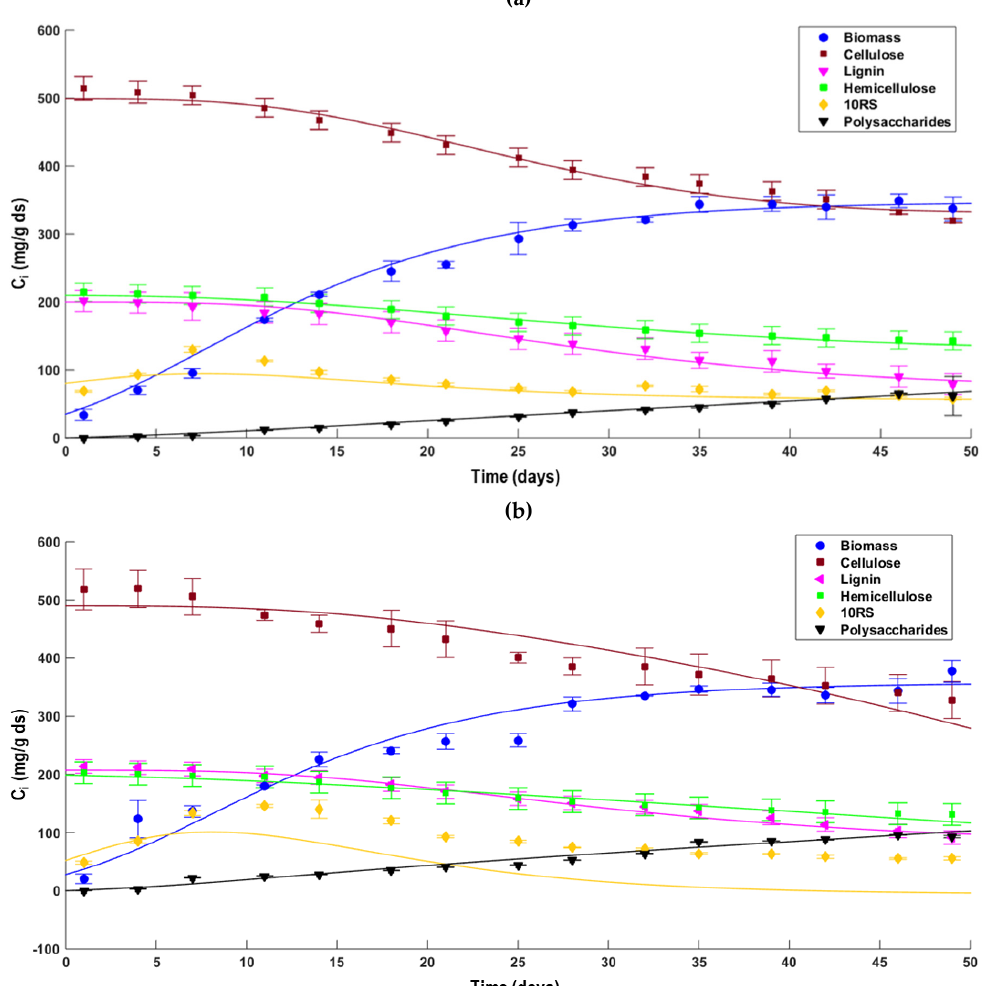
Figure 5. Time profile of cell biomass, polysaccharide production, and cellulose, hemicellulose, and lignin degradation by T. versicolor grown on different solid media. ( a ) Kinetic behavior for F7 medium. ( b ) Kinetic behavior for F11 medium. The continuous lines were calculated by the model proposed. The values for reducing sugars are multiplied by 10; C i : concentration, ds: dry solid, RS: reducing sugars.